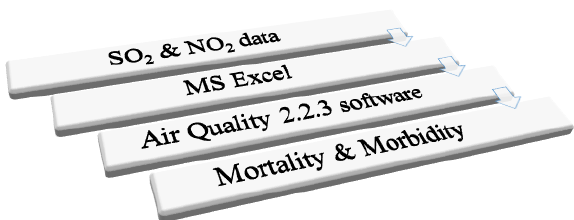
Fig.2 Data processing with use of Air Q 2.2.3